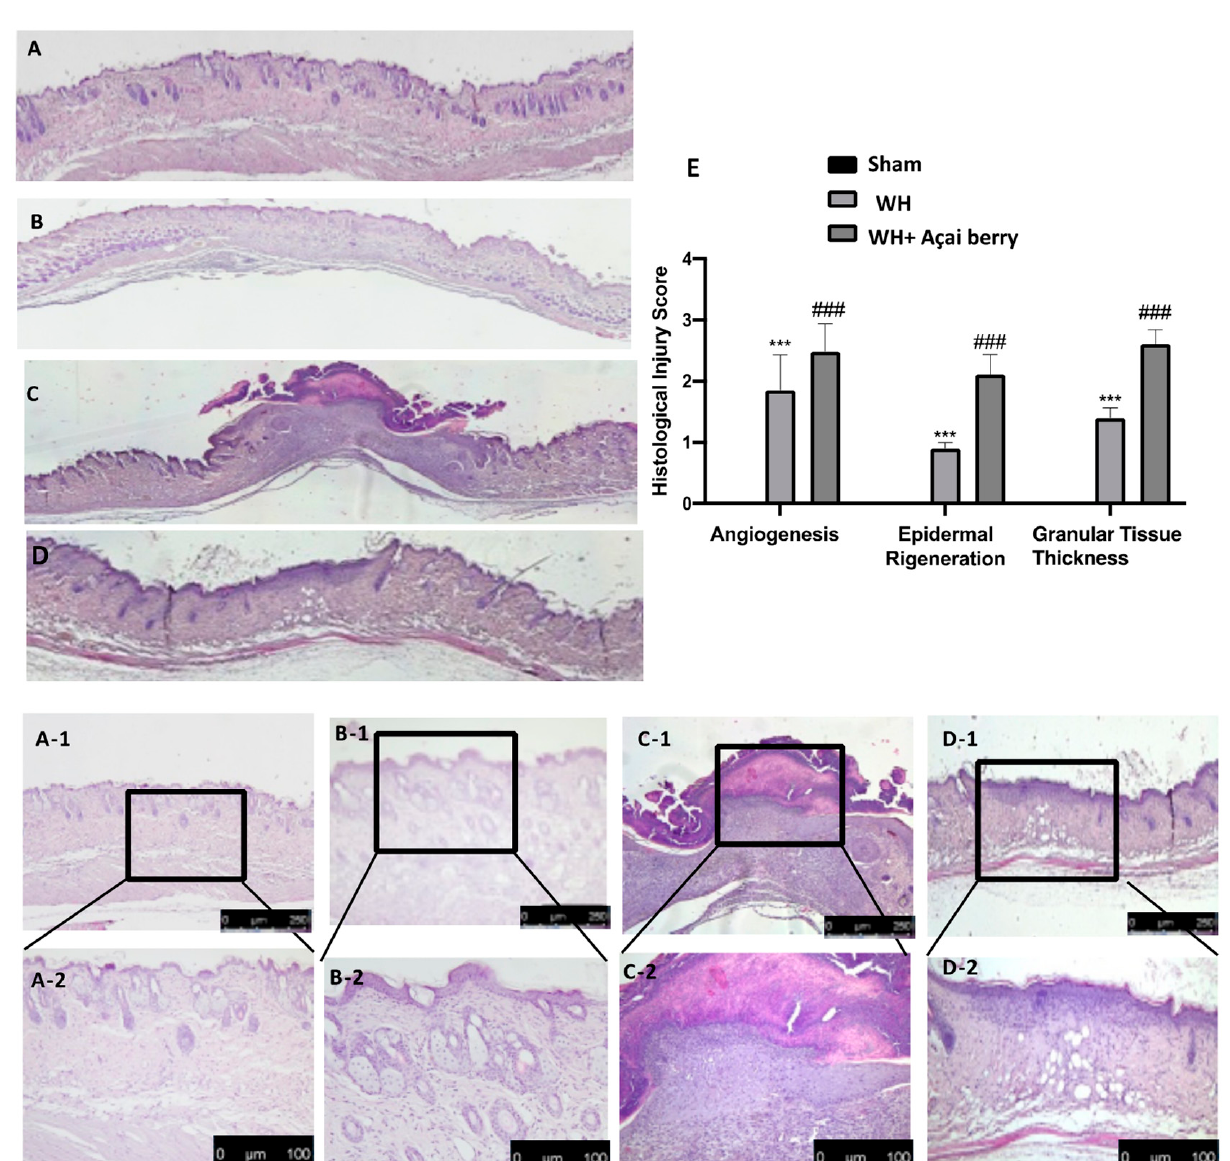
WH group (Figure 2B,B-1,D), as compared to the sham group (Figure 2A,A-1,D). Açai berry administration significantly reduced mast cell recruitment (Figure 2C,C-1,D).